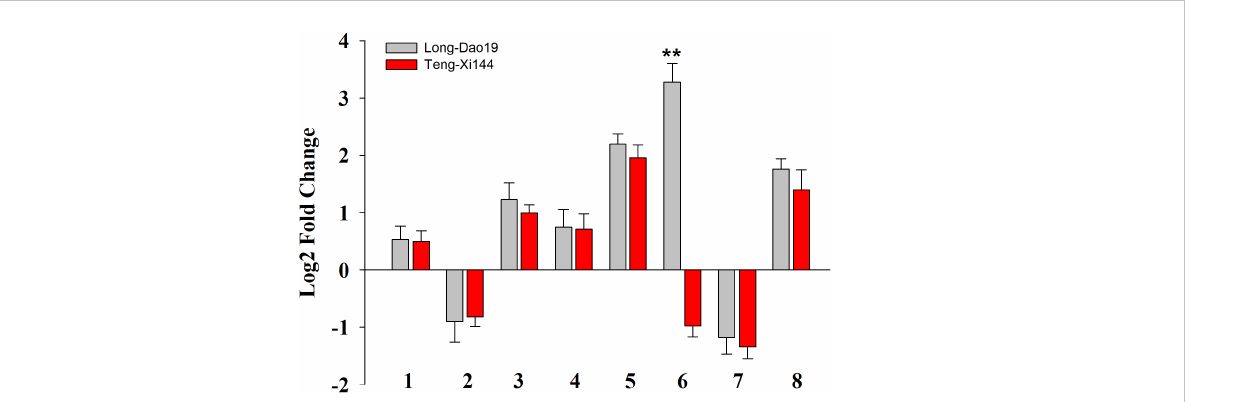
FIGURE 5 The expression level of selected genes in LD19 and TX144 12h after exposure to salt stress. Log2-fold change was calculated for gene expression under salt stress compared with control. 1 – 8 represents the genes used for expression analysis. 1-LOC_Os04g41510; 2-LOC_Os04g41520; 3-